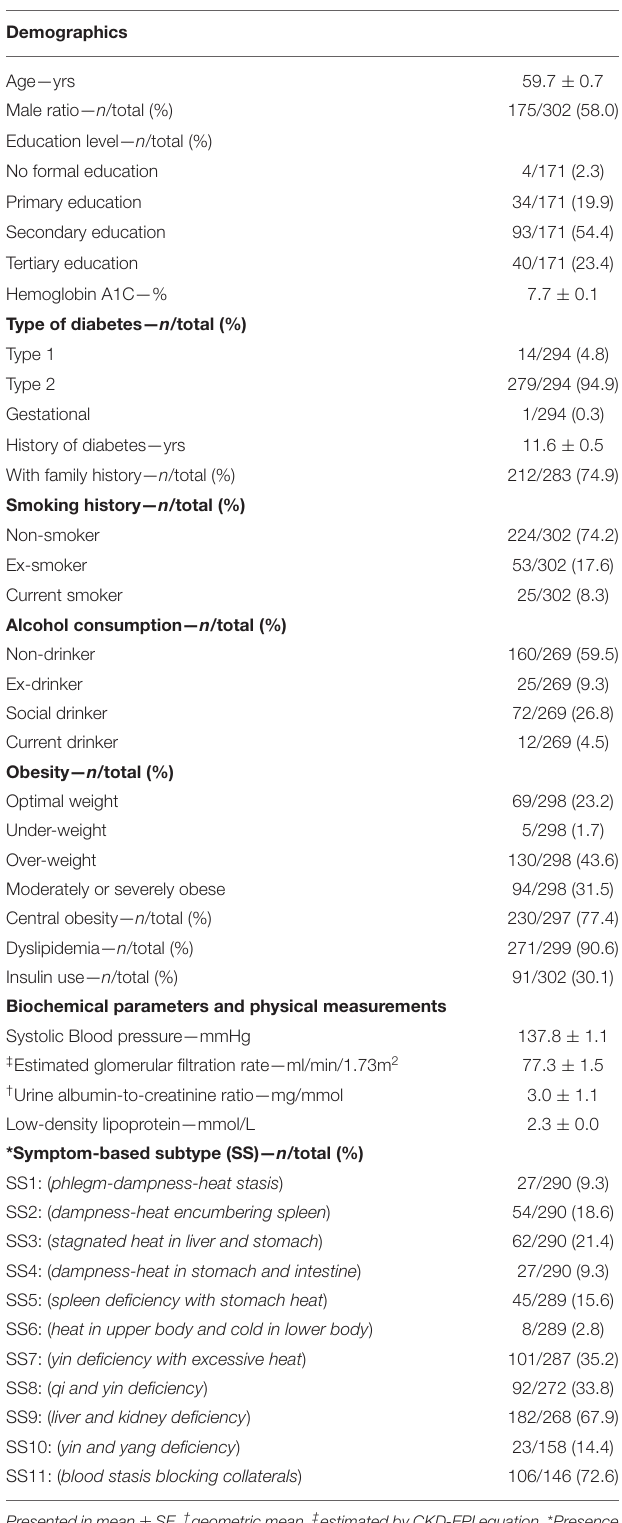
TABLE 2 | Patient demographics of validation